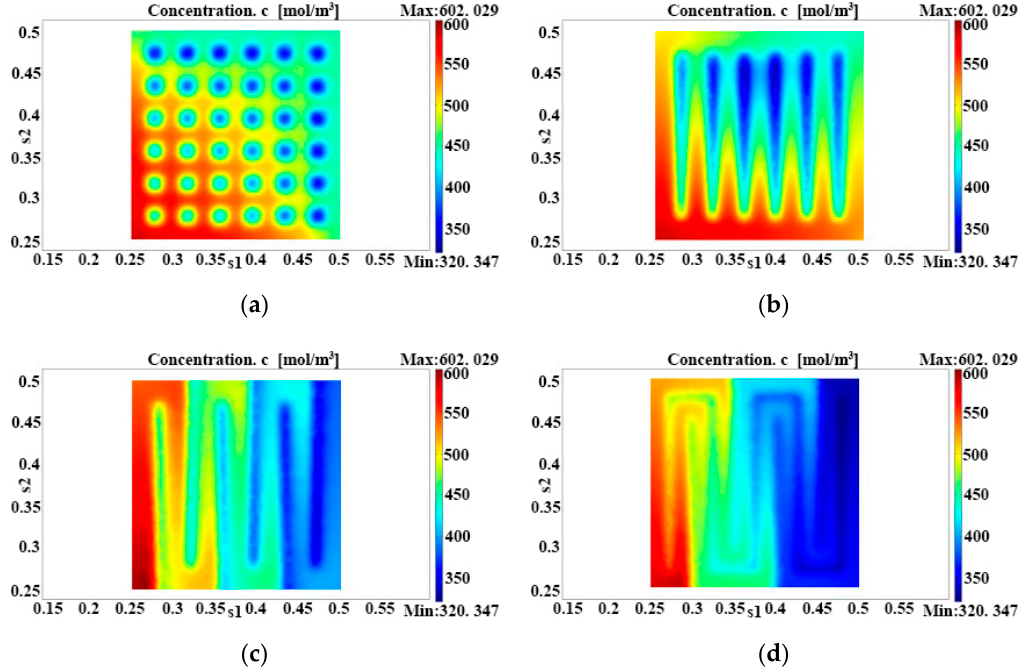
Figure 4. Methanol concentration distributions at the catalyst layers under ( a ) grid flow fields, ( b ) parallel flow fields, ( c ) single ‐ serpentine flow fields, and ( d ) double ‐ serpentine flow fields.